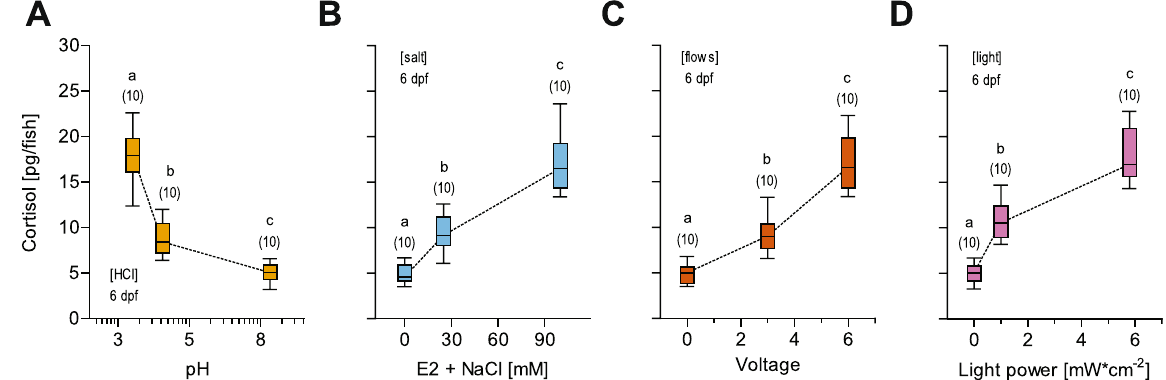
Figure 1. Stressors. ( A – D ) Whole-body cortisol in wild-type larvae (boxplots, whiskers: min to max, sample size in parentheses above the boxplots) as a function of stressor intensity: ( A ) pH drop (orange), ( B ) hyperosmotic medium (blue), ( C ) strong flows (vermilion) and ( D ) a squared pulse of light (purple). In all cases, stressor exposure increases whole-body cortisol in an intensity-dependent manner. Letters indicate results of Bonferroni’s tests ( p < 0.001) after one-way